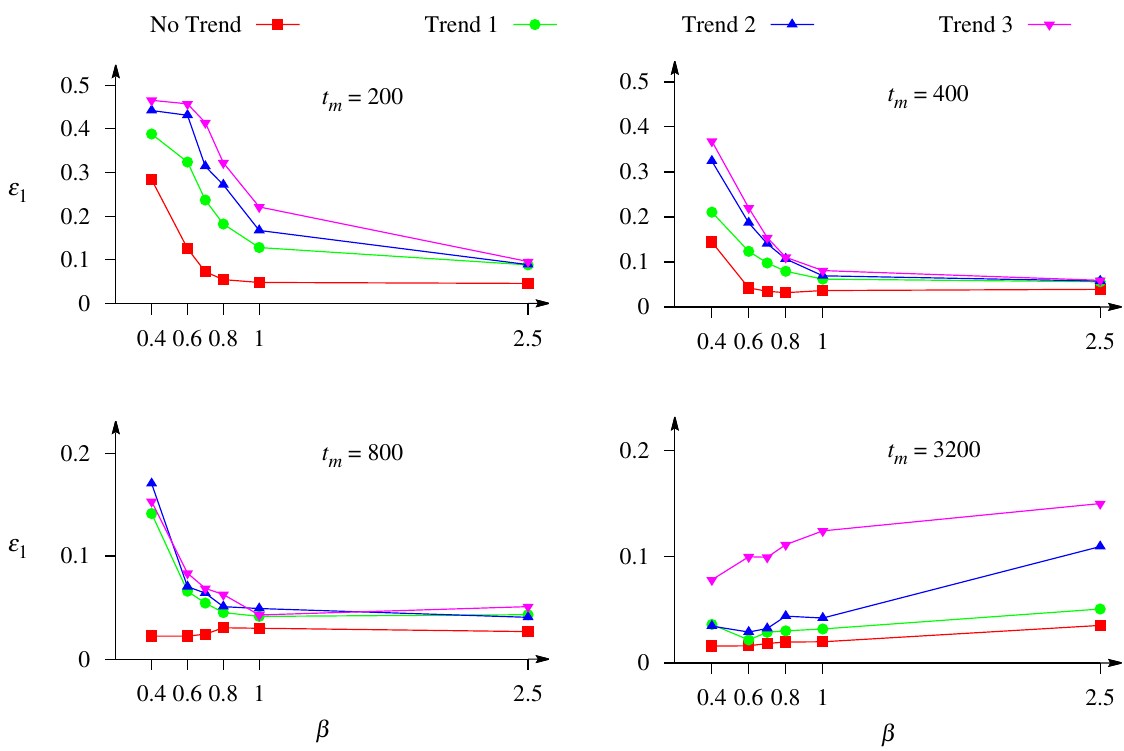
Figure 7. The relative error, ε S , versus the Biot number, β , and the duration, t 1 response is affected by white Gaussian noise with σ = 0 . 05 and the exponential trend of a different rate. The other parameters are as in Figure